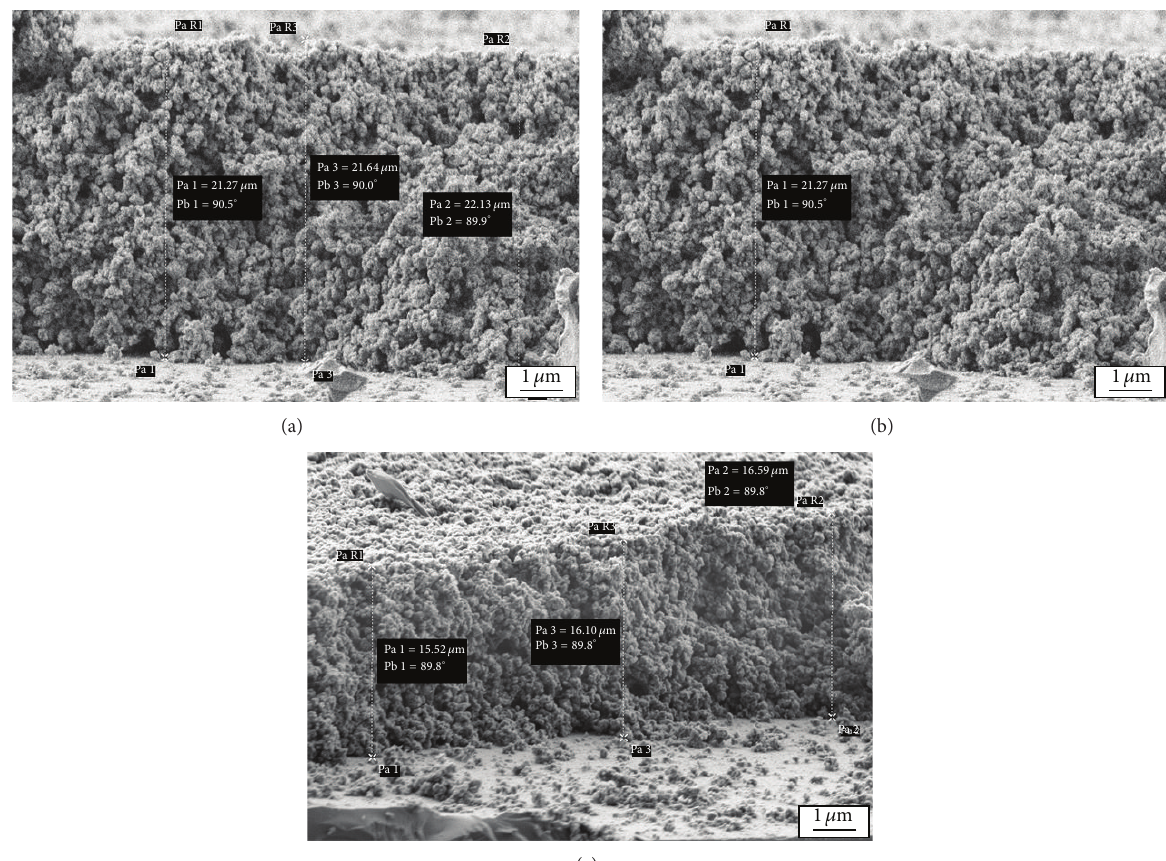
Figure 5: CNT/TiO 2 thin film’s average thickness of (a) 550 ∘ C, (b) 650 ∘ C, and (c) 750 ∘ C annealing temperature.